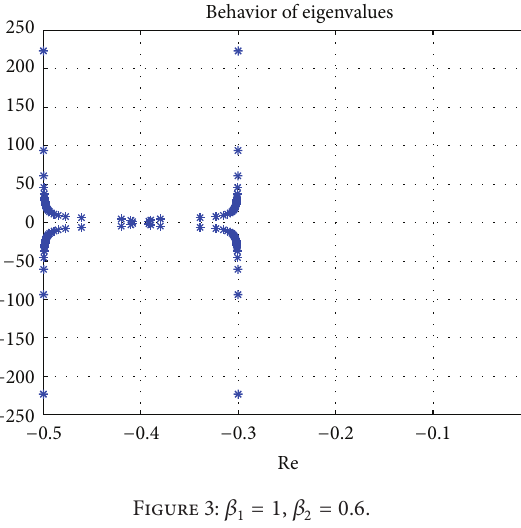
Figure 3: 𝛽 1 = 1 , 𝛽 2 = 0.6 .